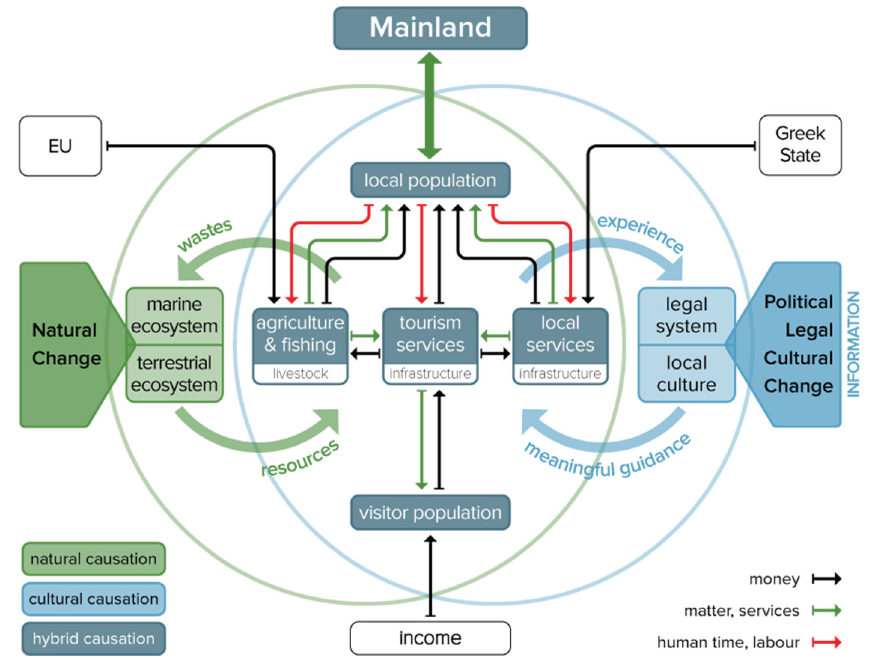
Figure 8. A comprehensive model of the socio-ecological system of Samothraki (adapted from [66]).